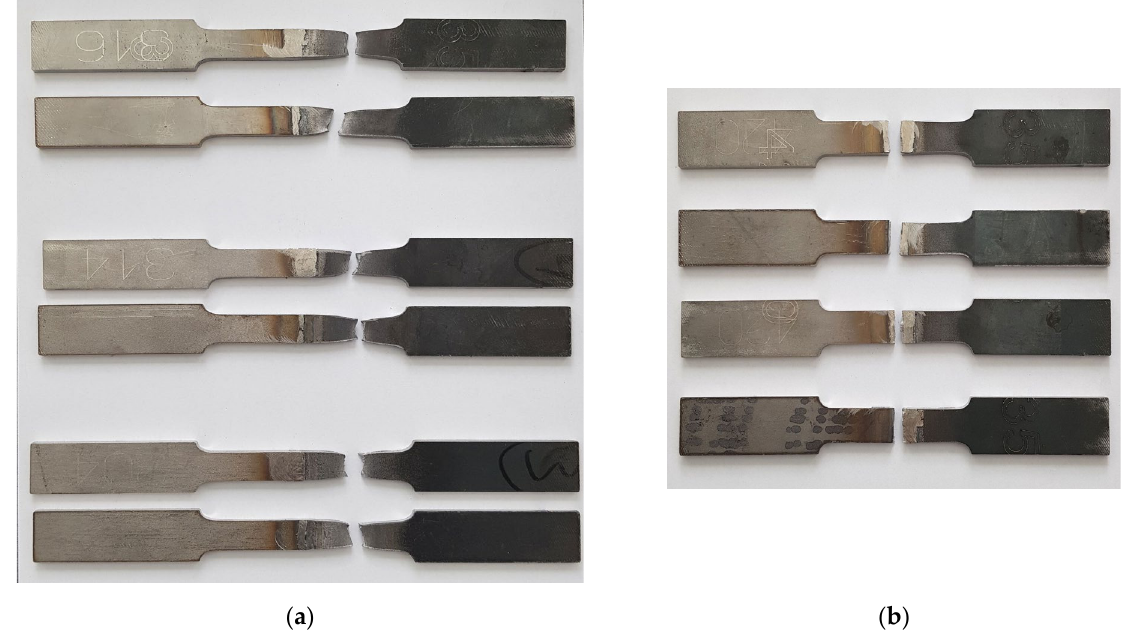
Figure 14. The fracture positions on tensile samples: ( a ) austenitic stainless steels/S355MC; ( b ) martensitic stainless steel/S355MC.